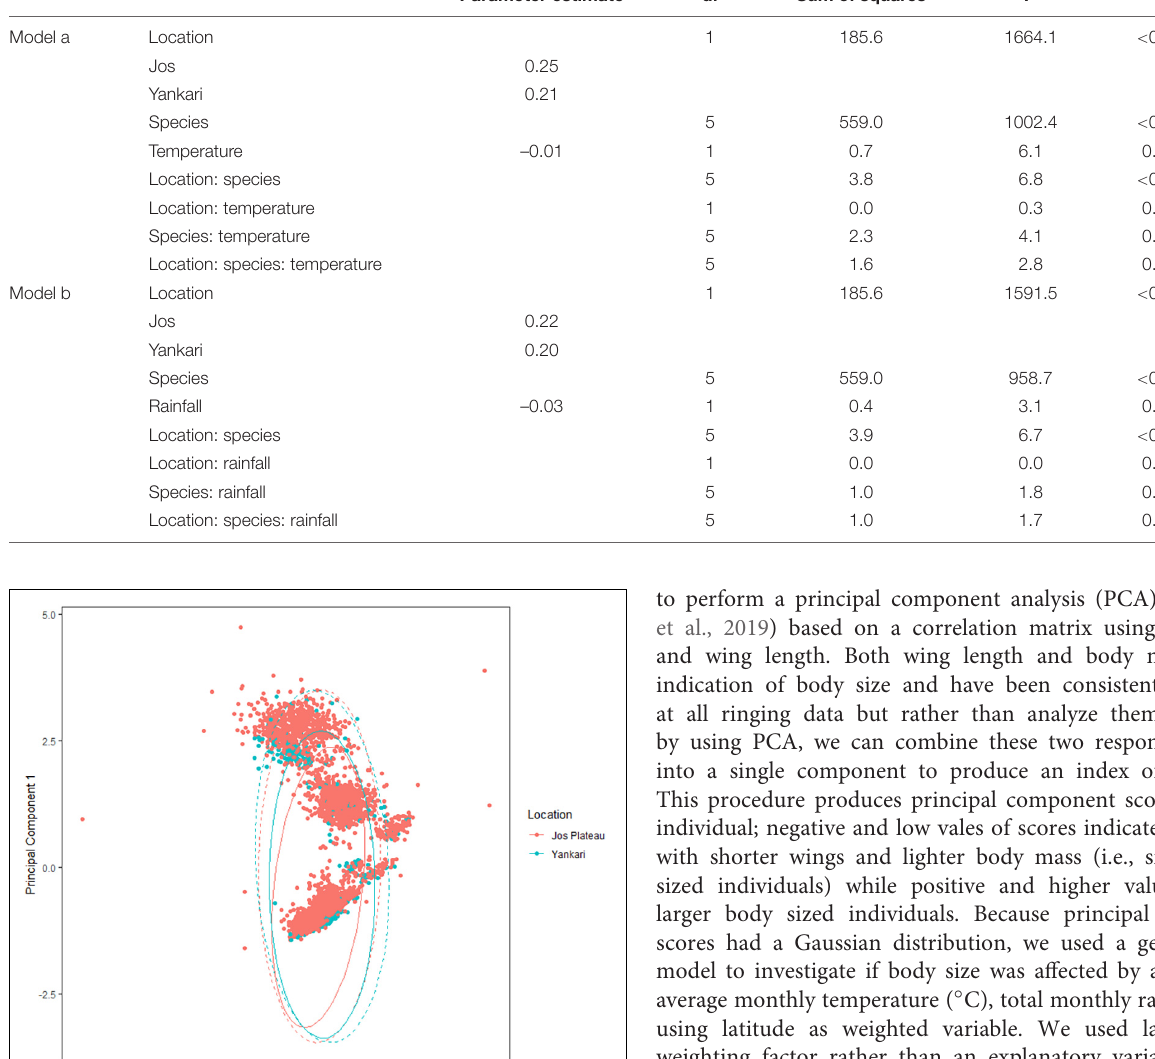
TABLE 1 | General linear model investigating the relationship between body size (PC1) with sites (lowland vs. montane), species, temperature (model a), and rainfall (model b) in southern Nigeria. Parameter estimate df Sum of squares F Model a